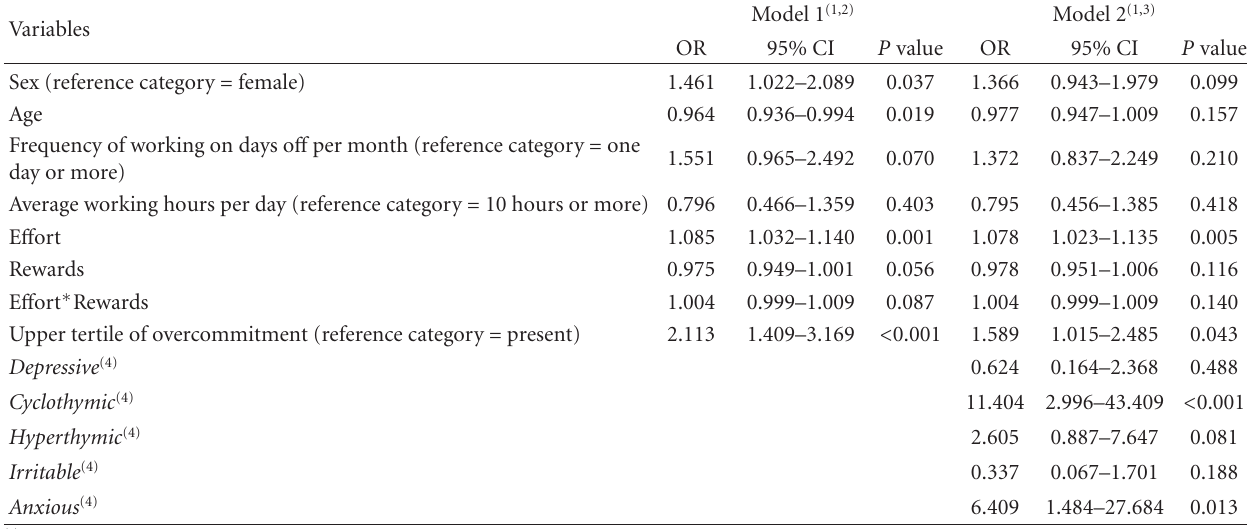
Table 5: Multivariate logistic regression model for the GHQ-12 ( N =